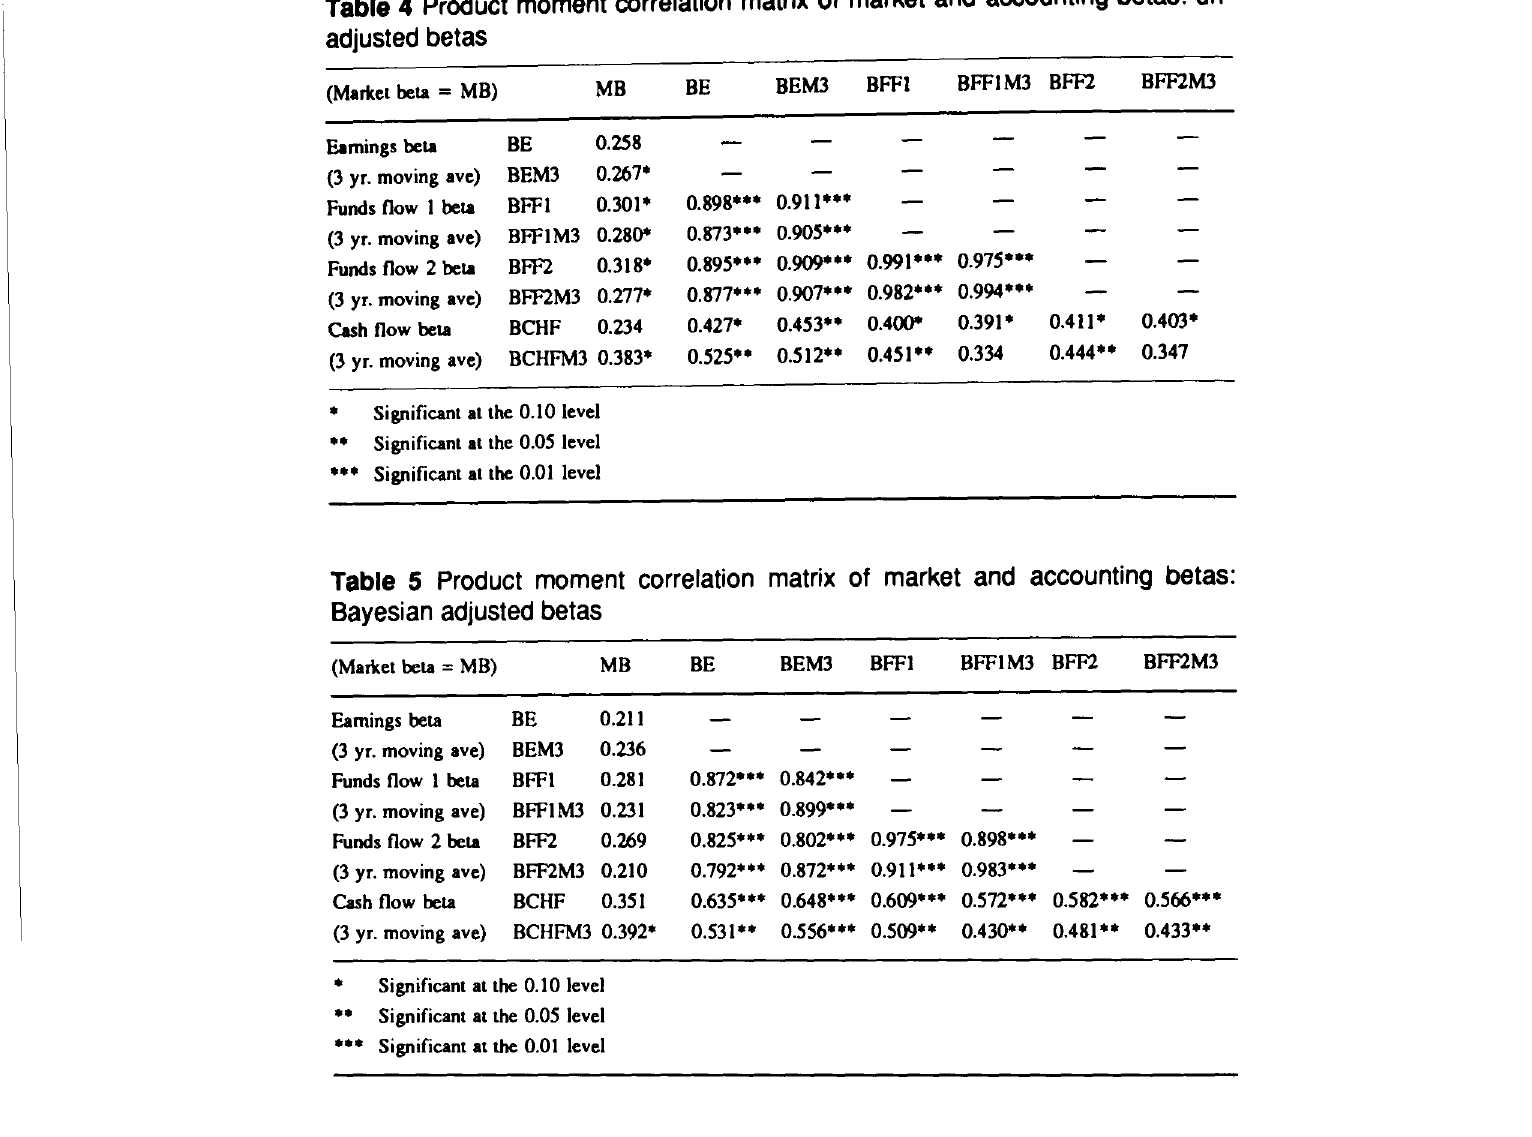
Table 4 Product moment correlation matrix of market and accounting betas: un- adjusted betas